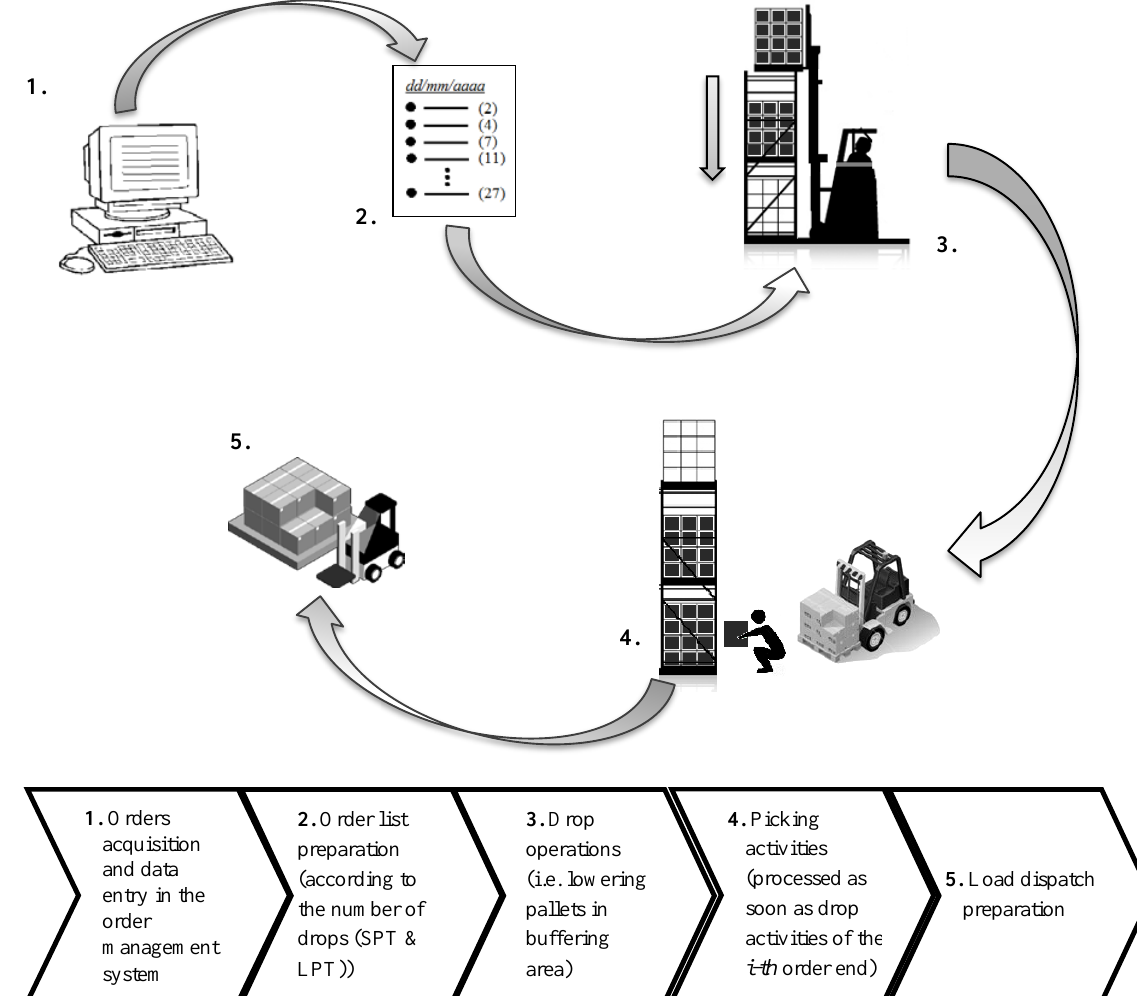
Fig. 2. Order dispatching